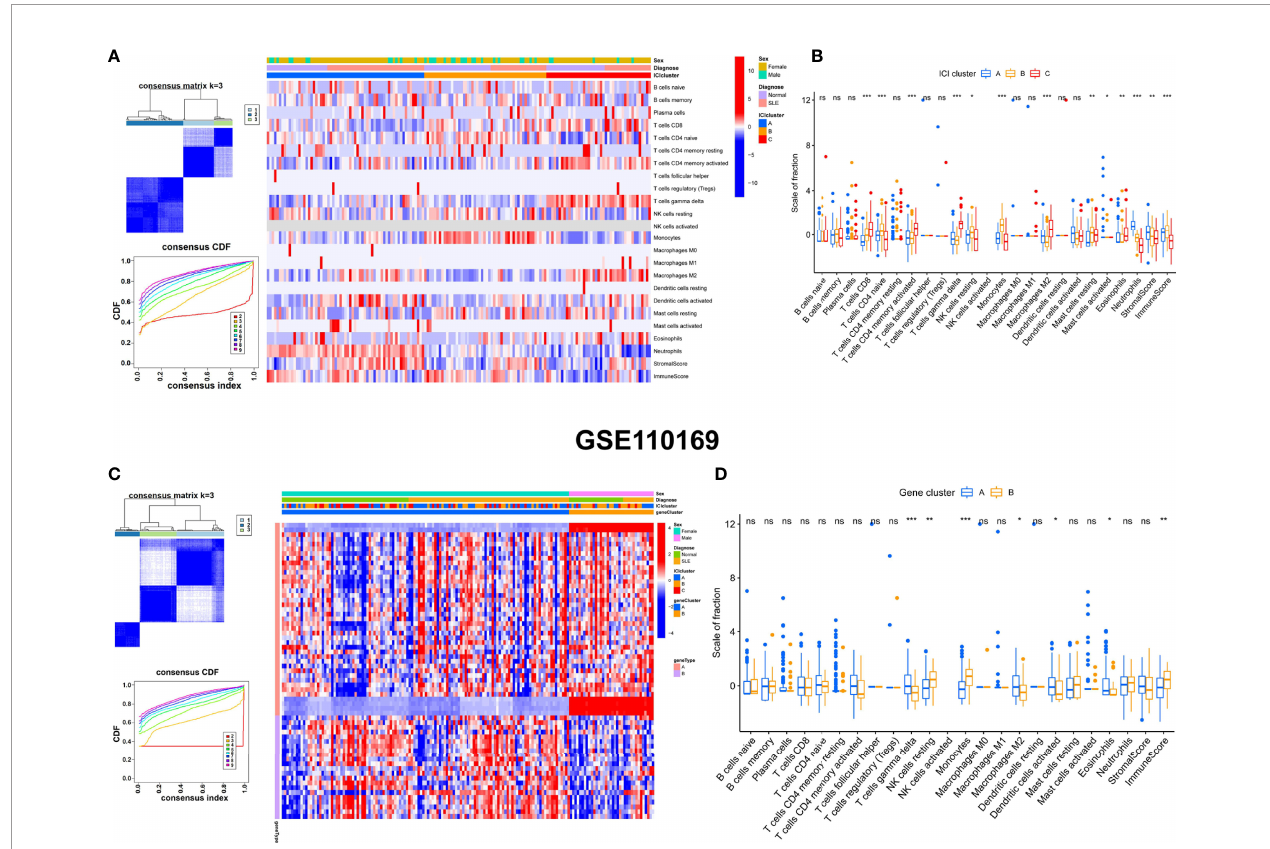
FIGURE 7 | Construction of gene clusters and ICI clusters and comparison of the differences in immune cells in GSE110169. (A) The optimal cluster number was k = 3. CDF curves (k = 2 – 9). Heatmap of the expression patterns of genes (red: high expression; blue: low expression). The upper columns consist of sex, m6A clusters, and gene clusters of SLE. (B) Boxplot of differential immune cell in fi ltration between three ICI clusters (blue: ICI cluster A; yellow: ICI cluster B; red: ICI cluster C). (C) The consensus clustering number was k = 3. CDF curves (k = 2 – 9). A heatmap of the expression patterns of genes is shown. The upper columns consist of sex, ICI clusters, and gene clusters of SLE. (D) Fractions of in fi ltrated immune cells in two gene clusters of the GSE110169 cohort. *p < 0.05; **p < 0.01; ***p < 0.001; ns, not signi fi